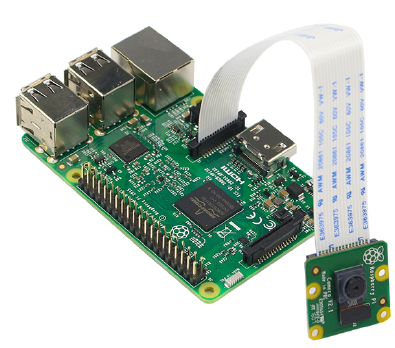
Figure 2. Raspberry Pi 3 with camera